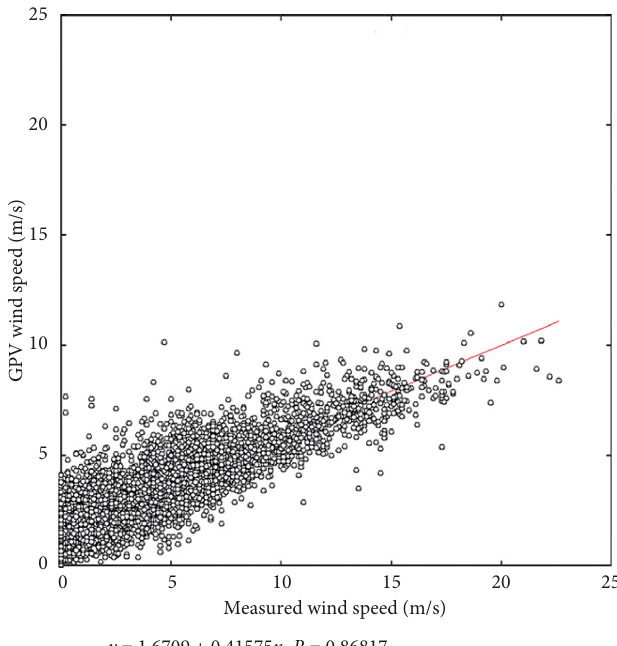
Figure 4: Scatter plot of measured data (5m above ground) and weather GPV data (10 m above ground) for nine months from July 2014 to March 2015.